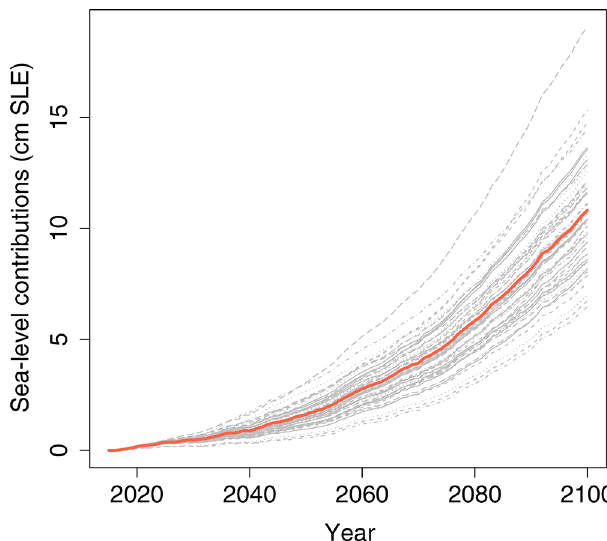
Figure 1. (a) Time evolution of the sea-level contribution (with re- spect to 2015) from the Greenland ice sheet (in cm sea-level equiv- alent, SLE). The results are the MIROC5 RCP8.5-forced MME of Goelzer et al. (2020). The straight red line is the temporal ensemble